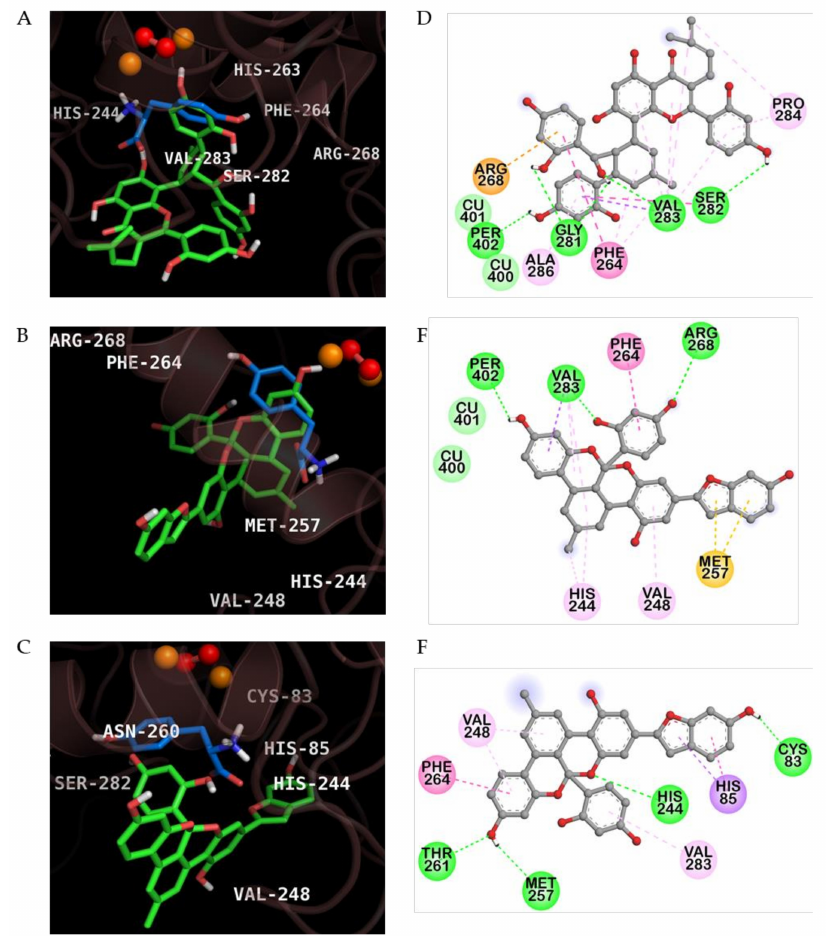
Figure 5. Inhibition mode of kuwanon G ( A ), mulberrofuran G ( B ), and albanol B ( C ) for the oxy-form mushroom tyrosinase catalytic site with L -tyrosine (blue stick). Two copper ions and peroxide ions are represented as orange and red spheres, respectively. Tested inhibitors are represented in green stick. 2D diagram of tyrosinase inhibition by kuwanon G ( D ), mulberrofuran G ( E ), and albanol B ( F